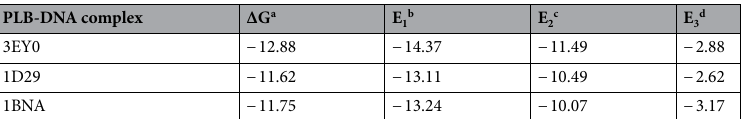
Table 3. The different binding energies (Kcal mol −1 ) participated in PLB-DNA complexes. a ΔG: The binding free energy determined in water by the scoring function. b E 1 : The intermolecular interaction energy, equals the sum of hydrogen bonding energy, van der Waals energy, electrostatic energy, and de-solvation free energy. c E 2 : The sum of hydrogen bonding, van der Waals, and de-solvation free energies. d E 3 : The electrostatic energy.